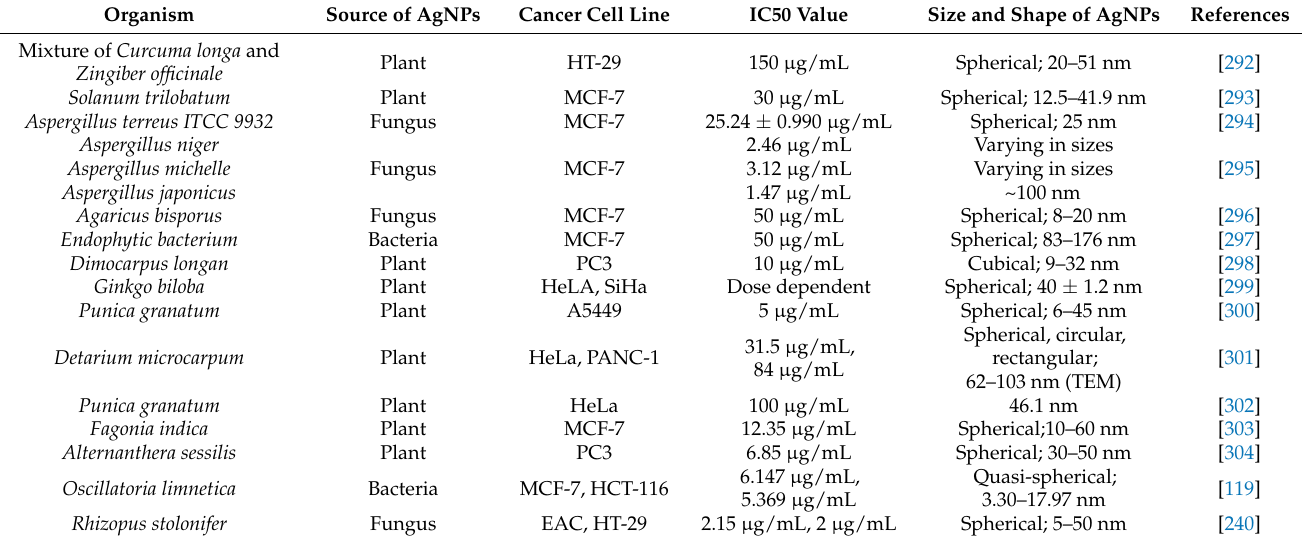
Table 5. The anticancer results of green synthesized